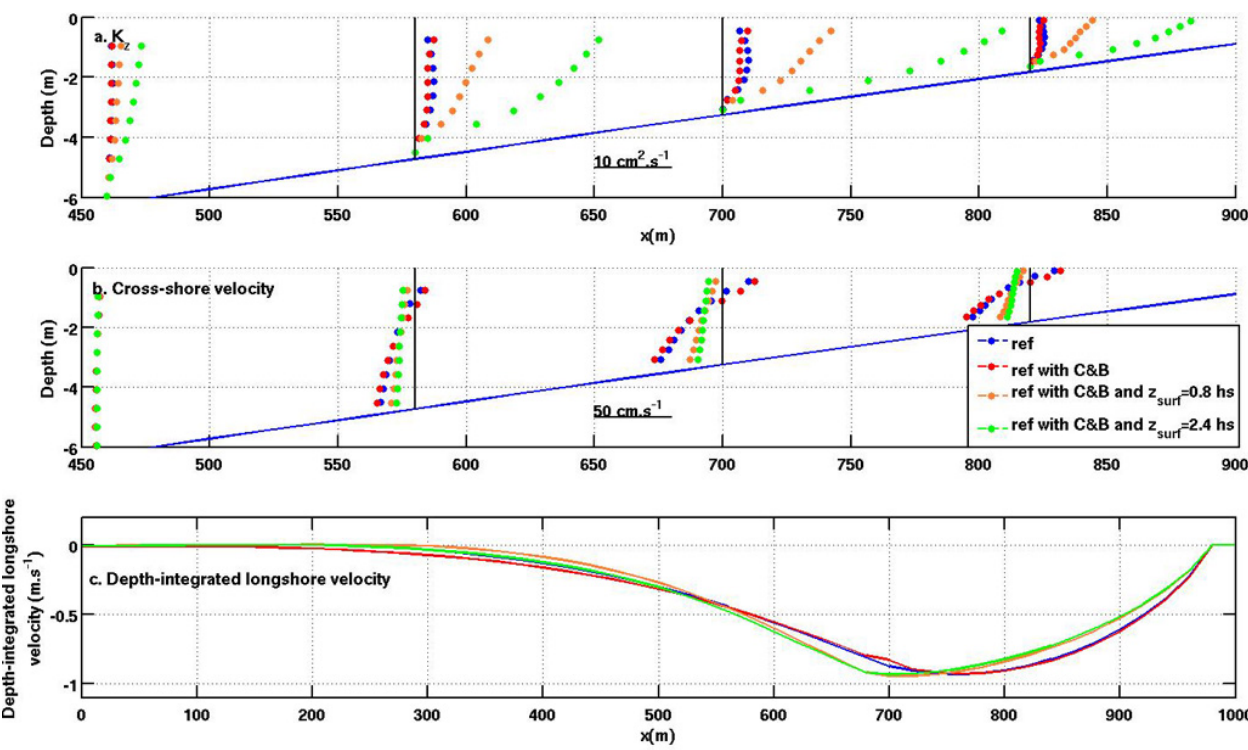
Fig. 4. Comparison of the vertical profiles of the vertical eddy viscosity (a) , the cross-shore velocities (b) and the cross-shore profile of the longshore depth-integrated velocities (c) with or without the parameterization of Craig and Banner (1994)) and different surface roughnesses in the turbulence closure. “ref” is the result for the reference